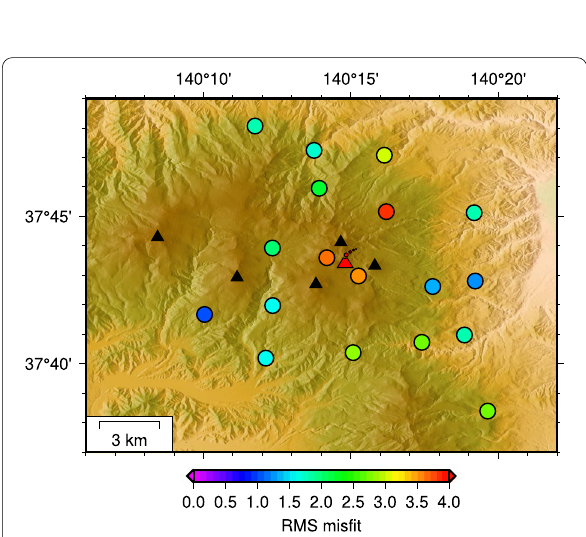
Fig. 4 RMS misfit of each site (colored